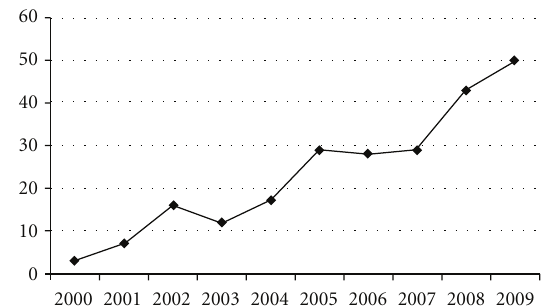
Figure 1: Number of patients undergoing a transvaginal ultrasound and meeting all study inclusion criteria, selected per year.